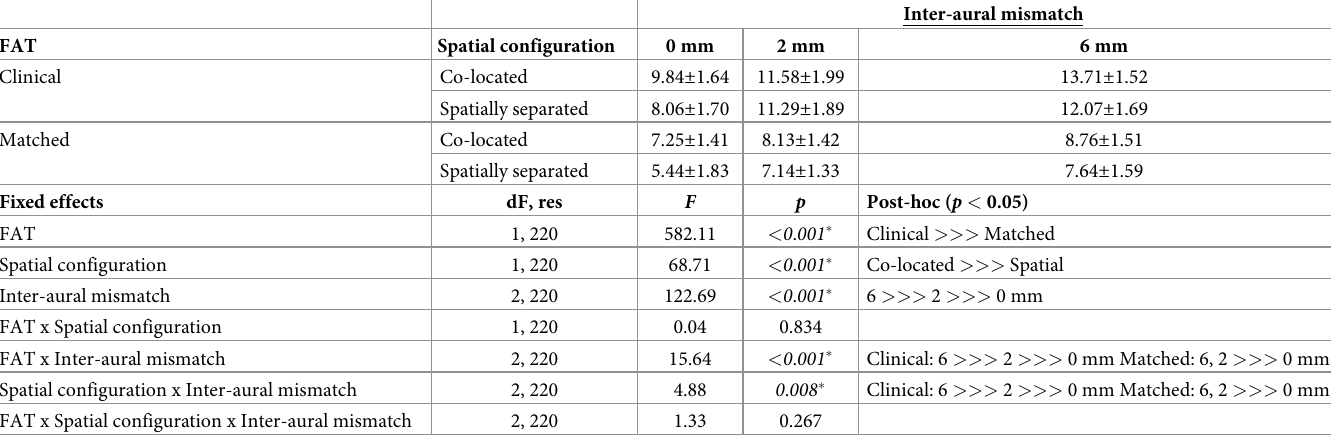
Table 2. SRTs for the FAT, spatial configuration, and inter-aural mismatch conditions. Top: SRTs (mean ± standard deviation) with the clinical or matched FAT, with co-located or spatially separated target and maskers, and with 0, 2, or 6 mm inter-aural mismatch. Bottom: Results from LMM analysis of the SRT data.